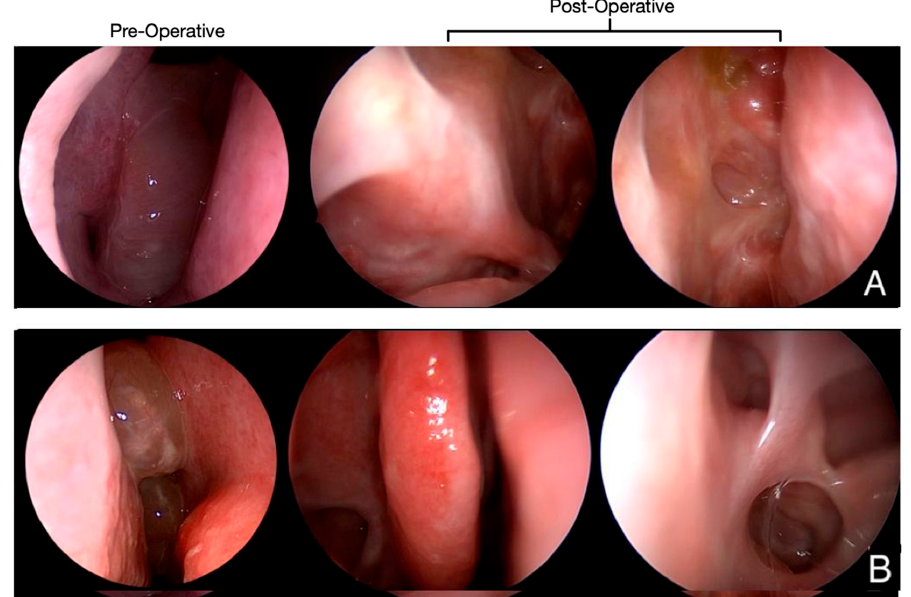
Figure 2. Pre- and post-operative nasal endoscopy (right nasal fossa). ( A ) = patient #1. Pre-operatively, obstructive polypoid formation is observed (NPS = 4). At examination after 12 months, nasal epithelial mucosa had been restored and no recurrence of nasal polyps is observed (NPS = 0). Middle turbinate was sacrificed. Middle antrostomy as well as ethmoidectomy are still open. Surgical scars obliterate sphenoidotomy, with no purulent discharge; ( B ) = patient #2. Preoperatively, sub-obstructive polypoid formations were shown (NPS = 3). At 12-month follow-up, healthy epithelium covers the whole surface of nasal fossa (NPS = 0). Surgical sinusotomies are wide open and correctly draining.